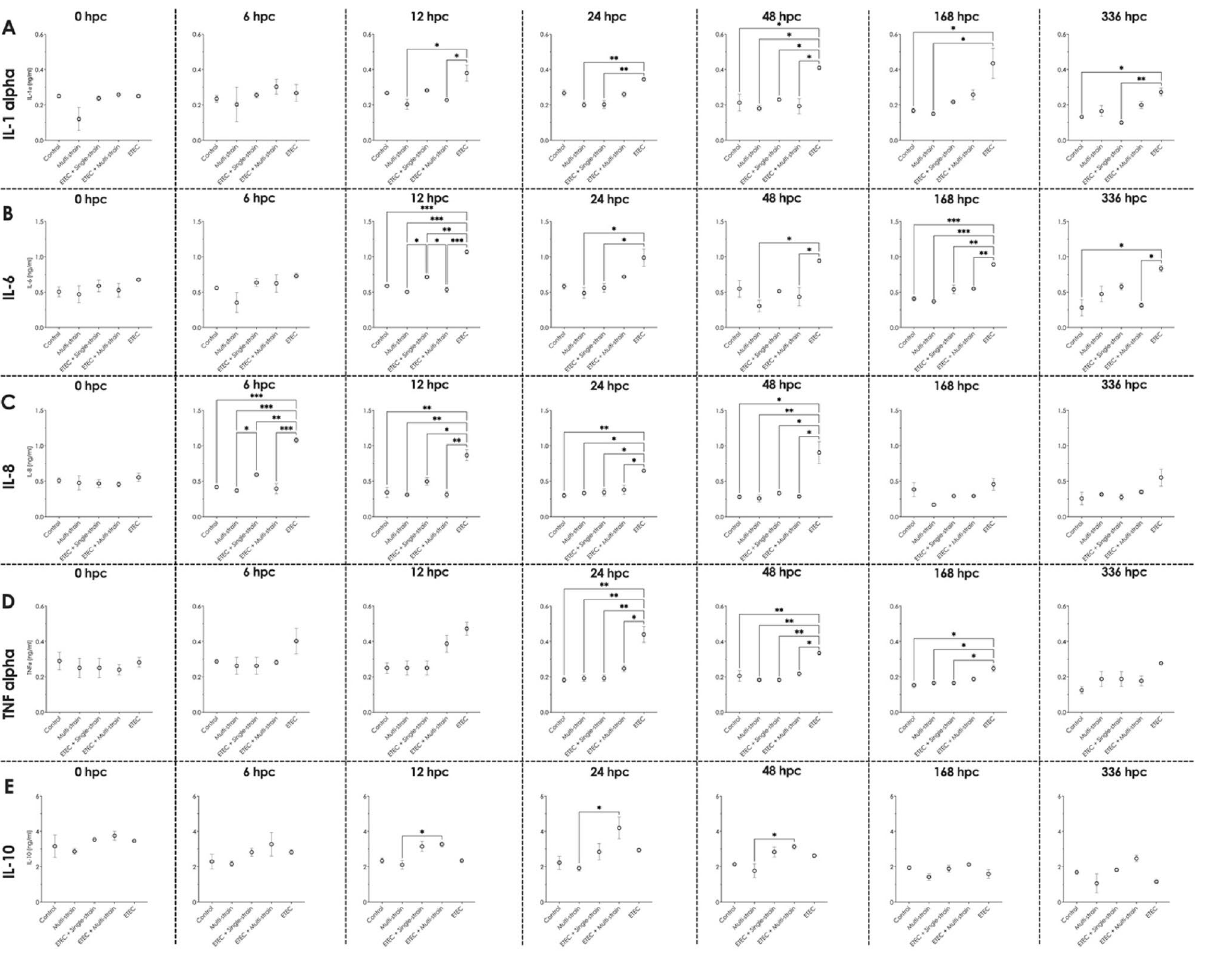
Figure 5. Serum cytokine concentrations at different time point in piglets after ETEC challenge (5 × 10 9 CFU). ( A ) IL-1α; ( B ) IL-6; ( C ) IL-8; ( D ) TNFα; and ( E ) IL-10. Control = oral supplementation with sterile peptone water followed by oral administration of sterile peptone water; Multi-strain = oral supplementation of double-coated multi-strain probiotic followed by oral administration of sterile peptone water; ETEC + Single- strain = oral supplementation of double-coated single-strain probiotic followed by oral challenged with ETEC; ETEC + Multi-strain = oral supplementation of double-coated multi-strain probiotic followed by oral challenge with ETEC; and ETEC = oral supplementation of sterile peptone water followed by oral challenge with ETEC. Values are presented as mean ± SEM of all replications in each group. The asterisks represent statistically significant differences (* P < 0.05, ** P < 0.01 and *** P < 0.001). hpc = hour